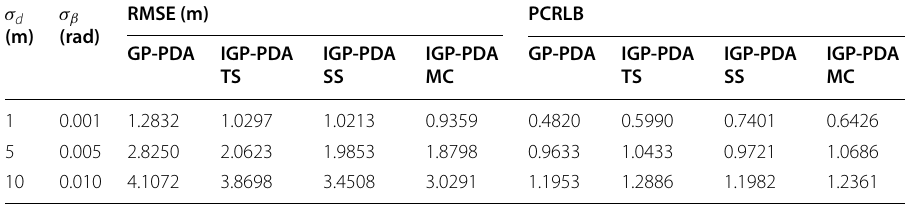
Table 2 Effect of measurement noise on contour estimates RMSE and PCRLB in first scenario σ β σ d (m) (rad)